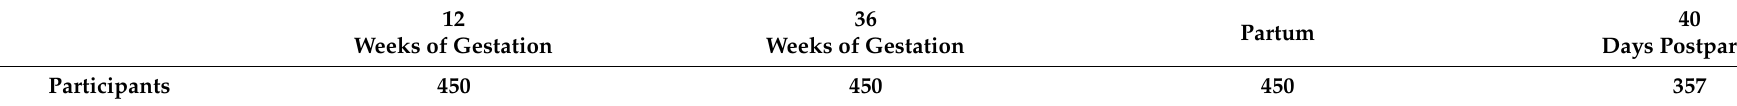
Table 1. Study design. Sample and variables